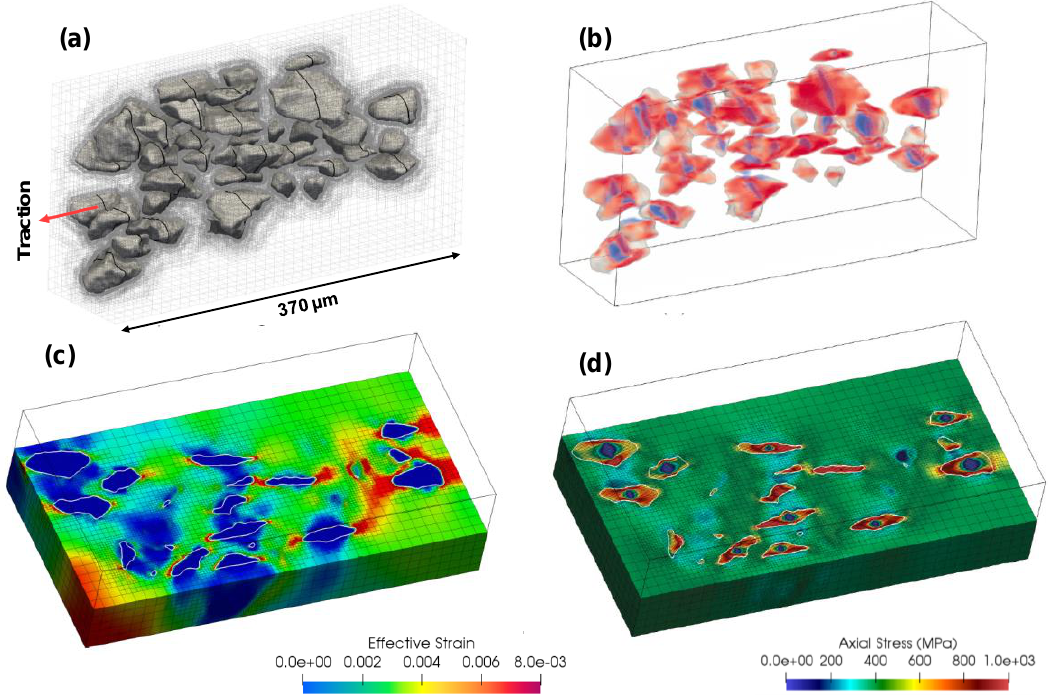
Figure 5. ( a ) Particle geometries in the oct-tree mesh wireframe. Fractured surfaces are denoted as black lines, ( b ) axial stress distribution on the particles, ( c ) effective strain on a slice parallel to the loading direction. Note that the traction is applied on left surface and the maximum effective strain is scaled to 0.008, and ( d ) axial stress on a slice parallel to the loading direction. The maximum axial stress is scaled to 1 GPa.